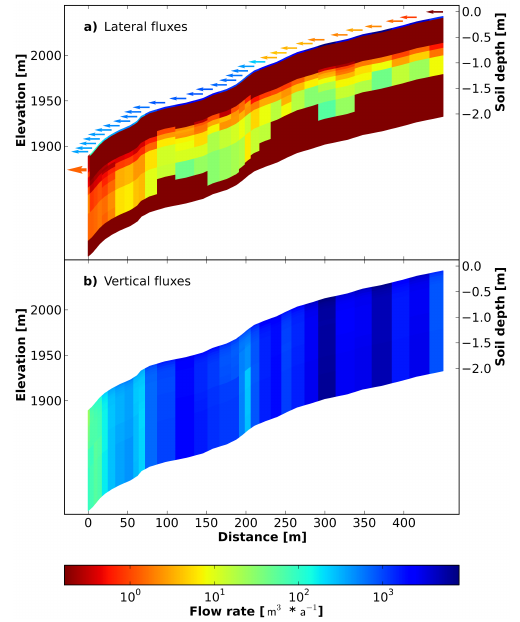
Figure 6. (a) Lateral and (b) vertical fluxes for the best modeled fit. Arrows indicate the amount of surface runoff and direct con- tribution to the outlet through subsurface flow. The maximum flow between storage compartments is 7.3 × 10 3 m 3 a − 1 , and the total observed flow leaving as well as entering the system accumulates to 37 × 10 3 m 3 a − 1